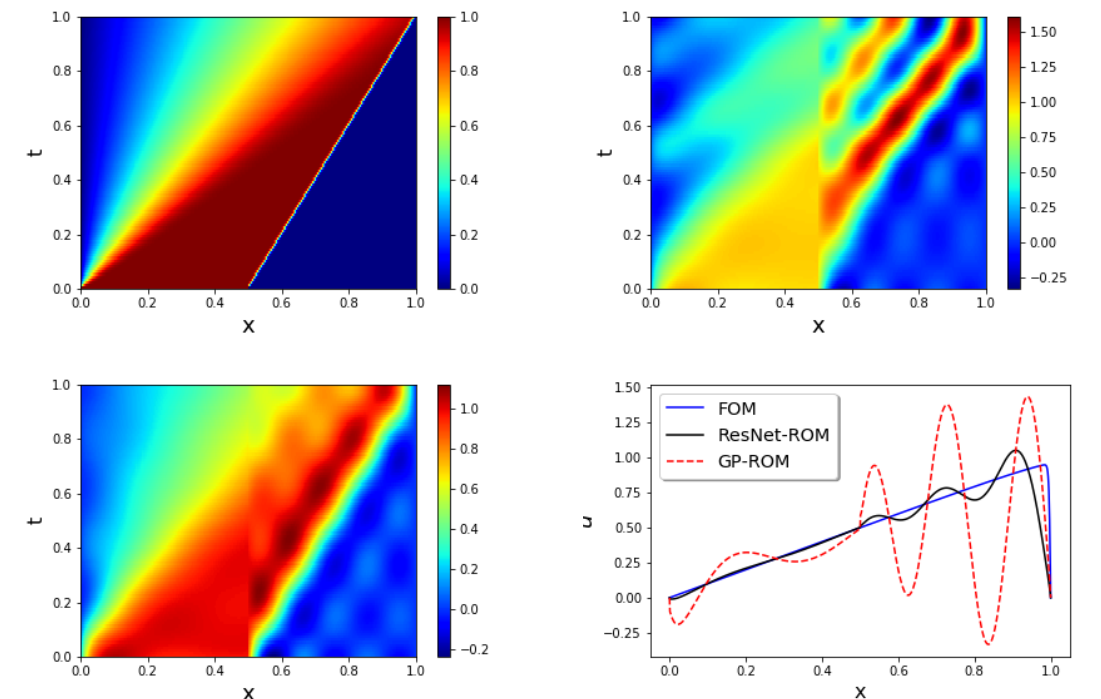
Figure 3. Reconstructive regime, Re = 1000: FOM ( top left ), GP-ROM ( top right ), ResNet-ROM ( bottom left ), and final time solution for all three simulations ( bottom right ). ResNet-ROM yields the most accurate solution.